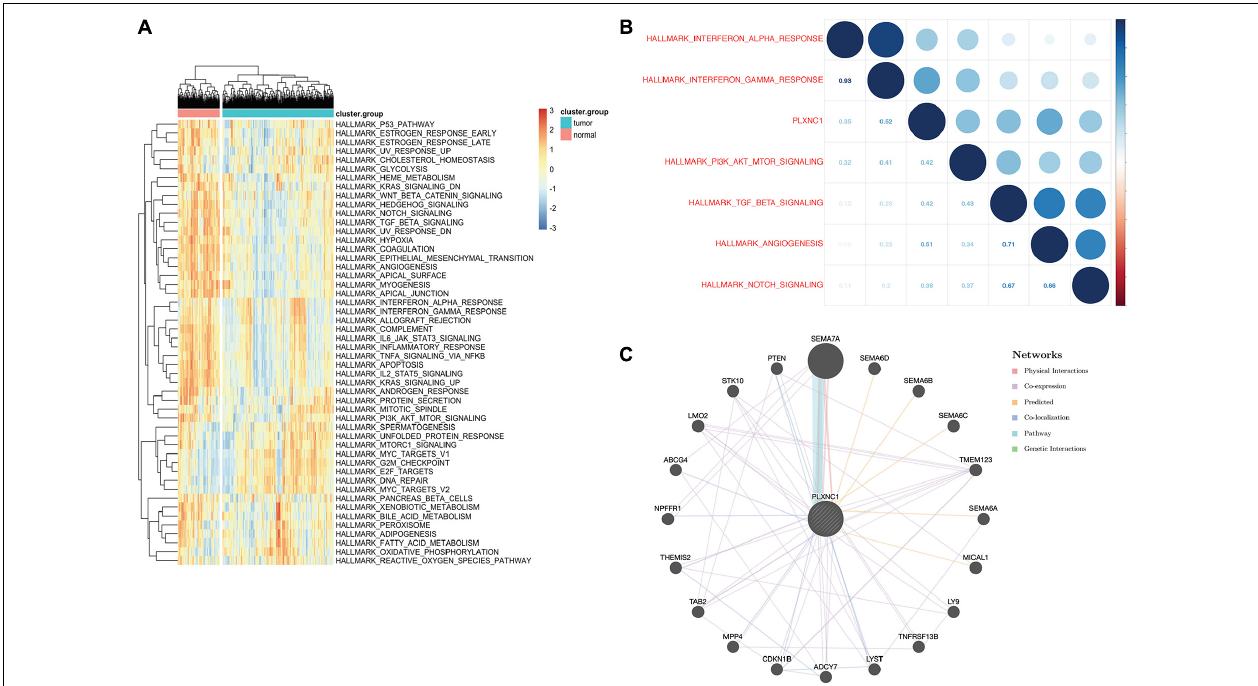
FIGURE 4 | (A) Identification of significant pathways correlated with PLXNC1 . Heatmap displaying 21 significant hallmark pathways differentially expressed in normal and STAD tissues. (B) Correlation between the top 5 significant hallmark pathways and PLXNC1 expression. PLXNC1 was significantly positively correlated with